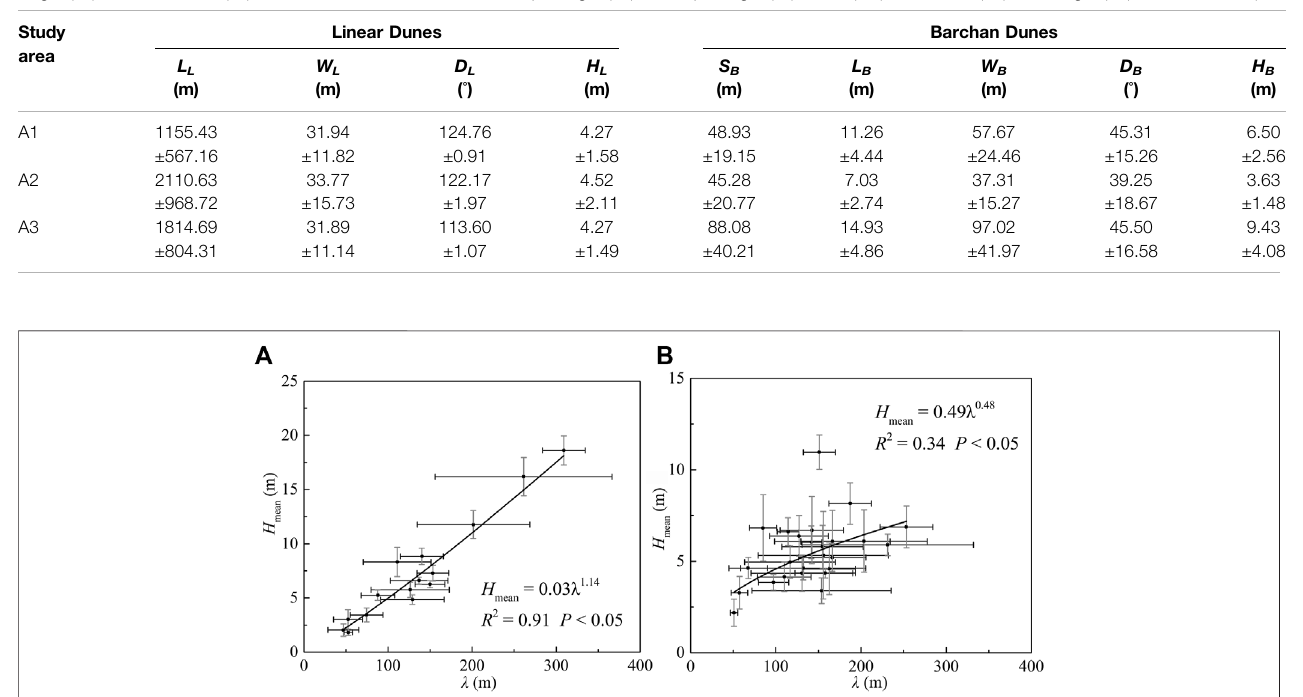
Frontiers in Earth Science |